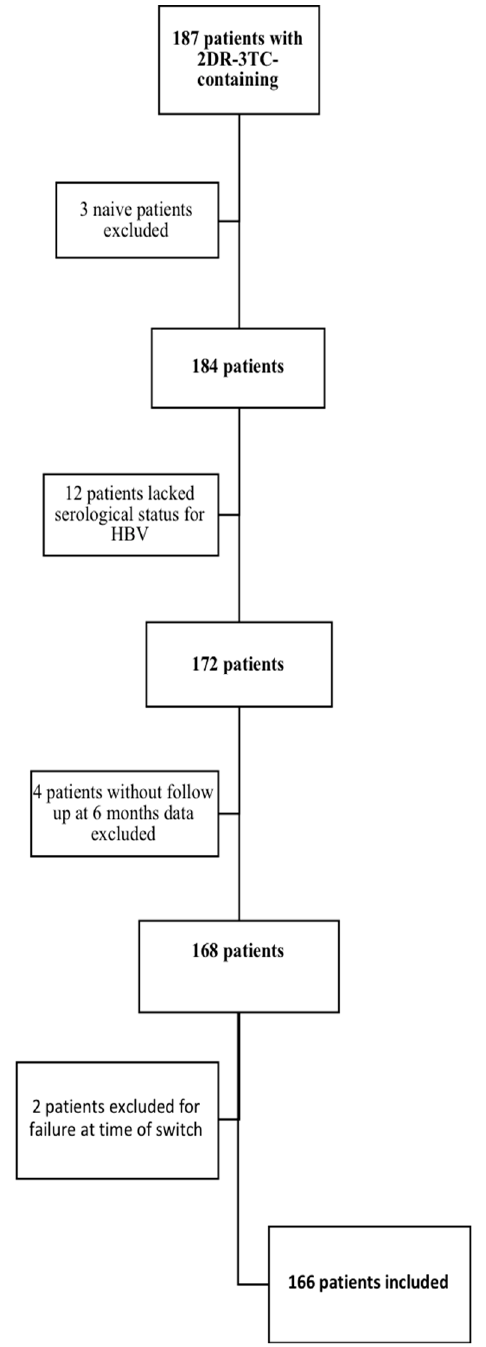
Figure 1. Patient inclusion algorithm.